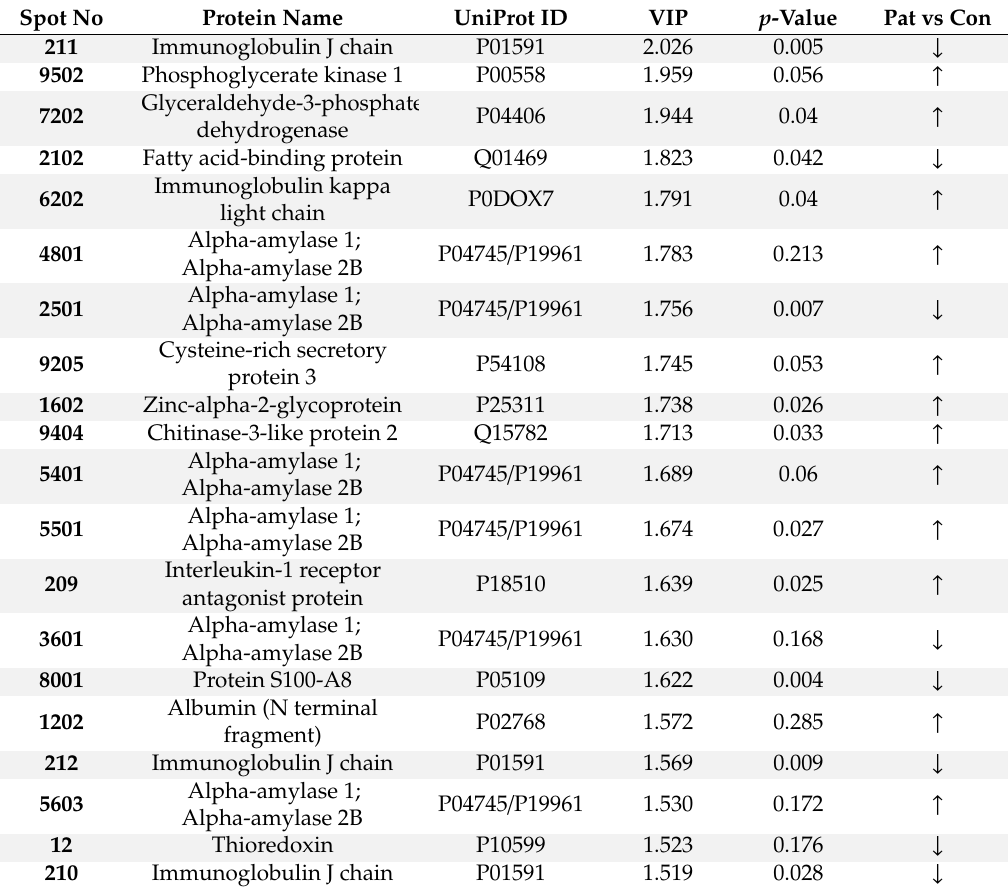
Table 2. Proteins altered in the saliva from patients compared to controls. Identified salivary proteins that were altered in patients (Pat) with temporomandibular disorder myalgia compared to healthy controls (Con). Proteins with a VIP above 1.5 in the orthogonal partial least-squares discriminant analysis model are shown. The p -value is according to the Mann–Whitney data analysis. Arrows ↑ and ↓ indicate up- and downregulated proteins in patients compared to